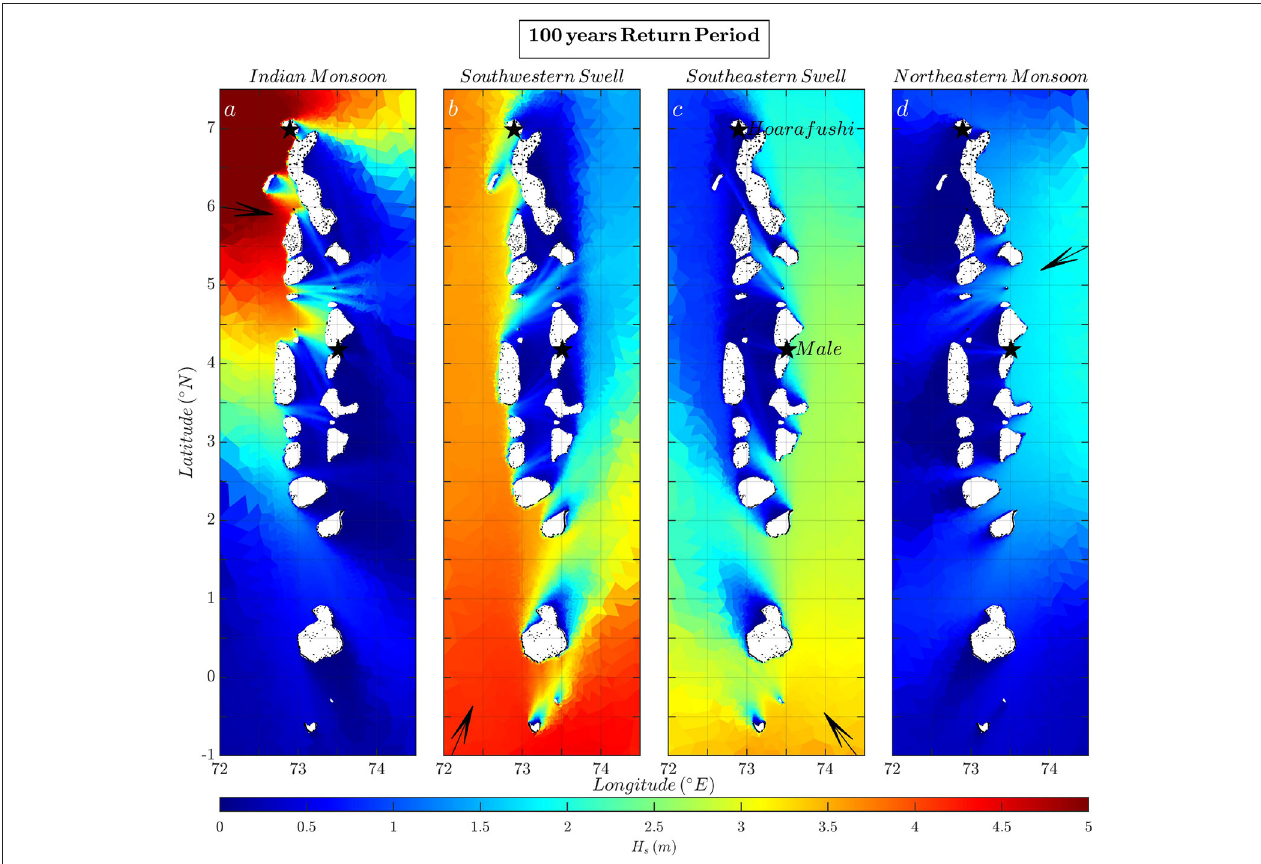
FIGURE 6 | Regional downscaling of the 100 year return period wave event performed with WaveWatch III model (see section 2.2 for the details) for each one of the wave components identified [ (a) Indian Monsoon, (b) Southwestern Swell, (c) Southeastern swell, and (d) Northeastern Mosoon]. Black arrow in each panel indicated the wave direction. Black stars indicate the position of Malé, the main city of the Maldives, and Hoarafushi, the island where the local modelling was